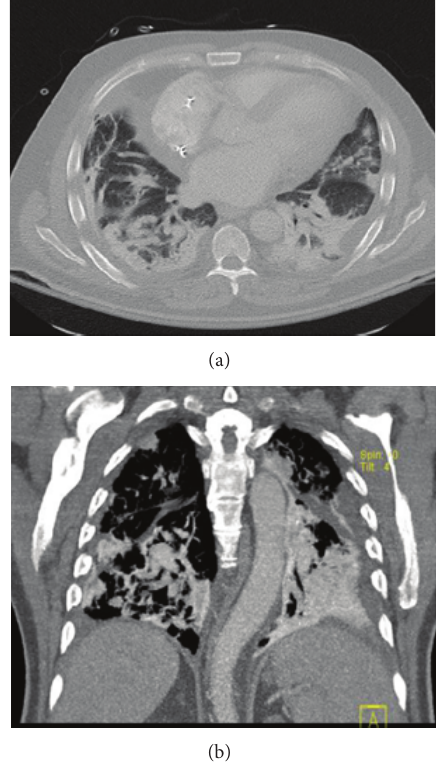
Figure 2: (a) and (b) CT chest with contrast showing high attenuation areas of multiple conglomerate consolidation in both lung bases ((a) axial cut; (b) coronal cut).